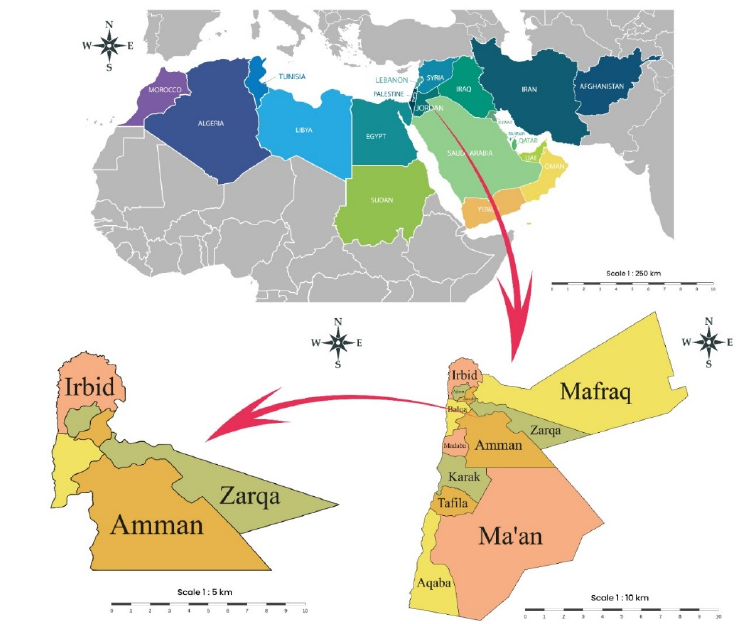
Fig. 1: Geographic location of the study area in the Jordan’s central and northern regions in Amman, Zarqa, and Irbid of Jordan